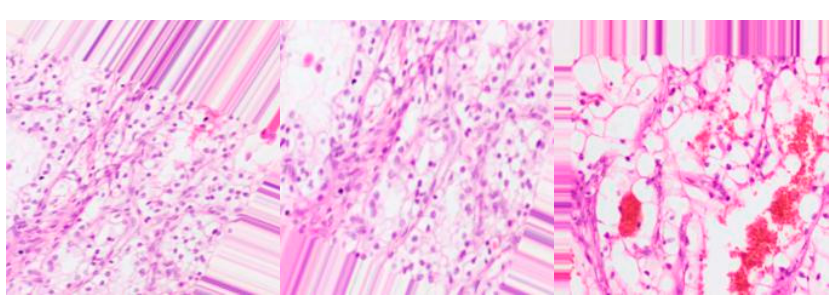
Figure 3. Data samples from grade 0, grade 1, and grade 2 classes.